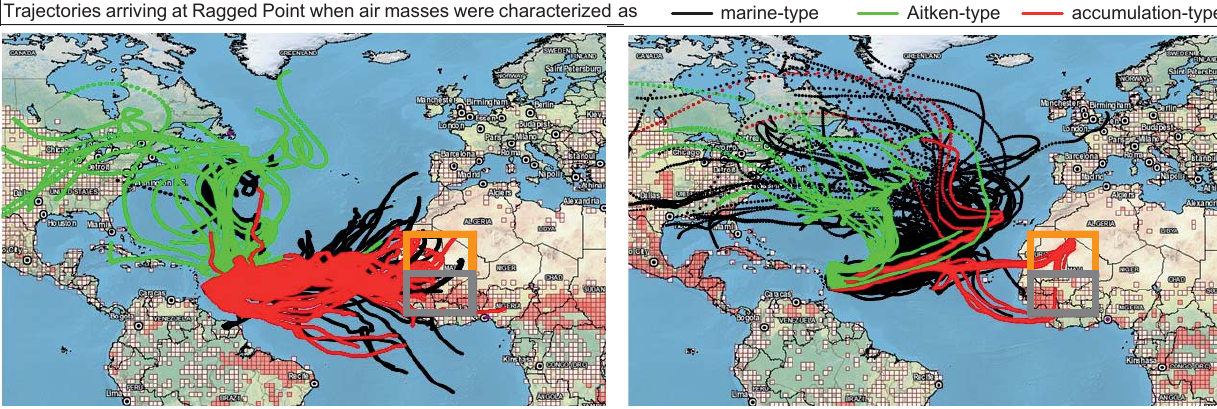
Figure 8. Ten-day back trajectories arriving at Ragged Point at a height of 500m. Trajectories were calculated every 4h (each calculation is shown as a separate dot, which is separately visible when air masses moved fast). The trajectories shown here are those arriving at Ragged Point during the measurement periods in November 2010 (left panel) and April 2011 (right panel). The map in the background was taken from the NASA FIRMS Web Fire Mapper. The orange and grey boxes represent those regions in the Sahara and Sahel, respectively, which a trajectory had to cross to be characterized as being influenced by either of them. More details are given in the